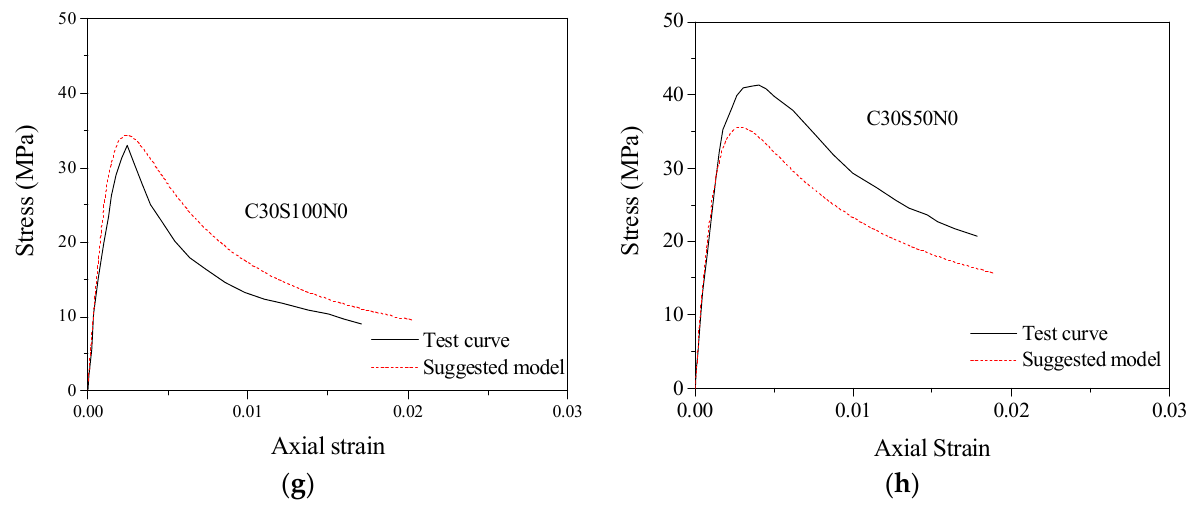
Figure 14. Performance of the stress–strain relationship curve model of stirrup-confined concrete columns: ( a ) SR5S20BN; ( b ) SR75S20BN; ( c ) SR25S40BN; ( d ) SR40S40BN; ( e ) R25S40CN; ( f )